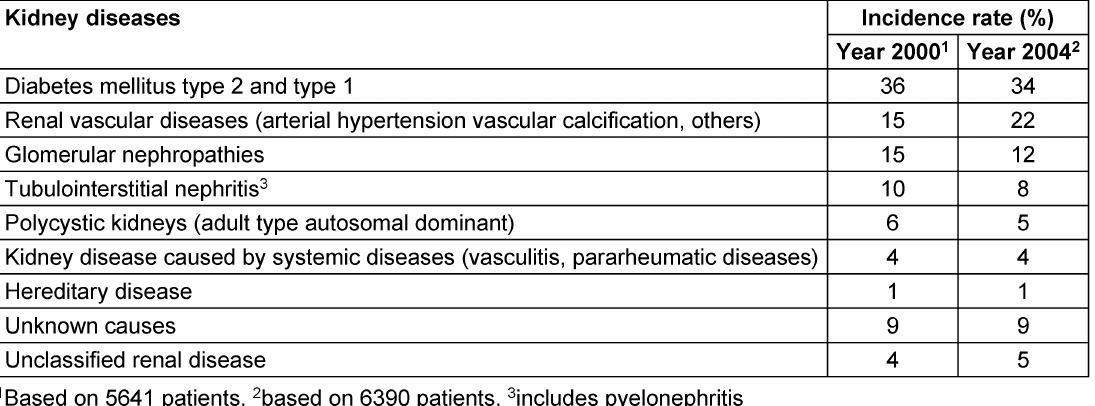
Dialysis Registry for the years 2000 and 2004